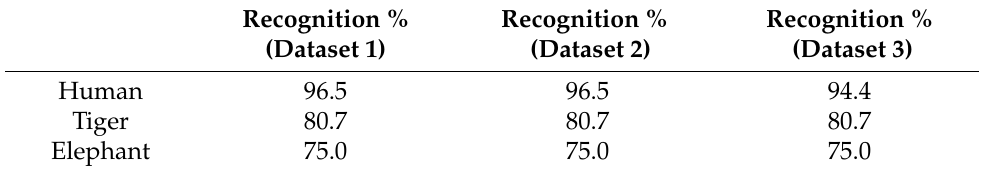
Table 5. Test results for three